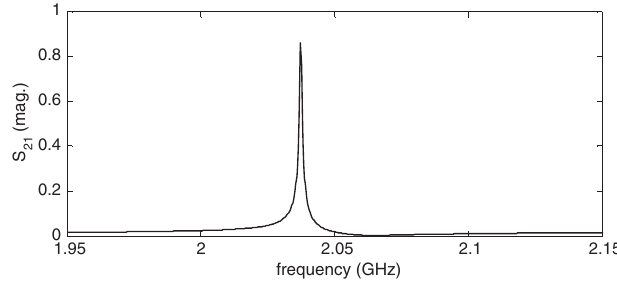
FIG. 3. Power transmission coefficient for the designed de- flecting